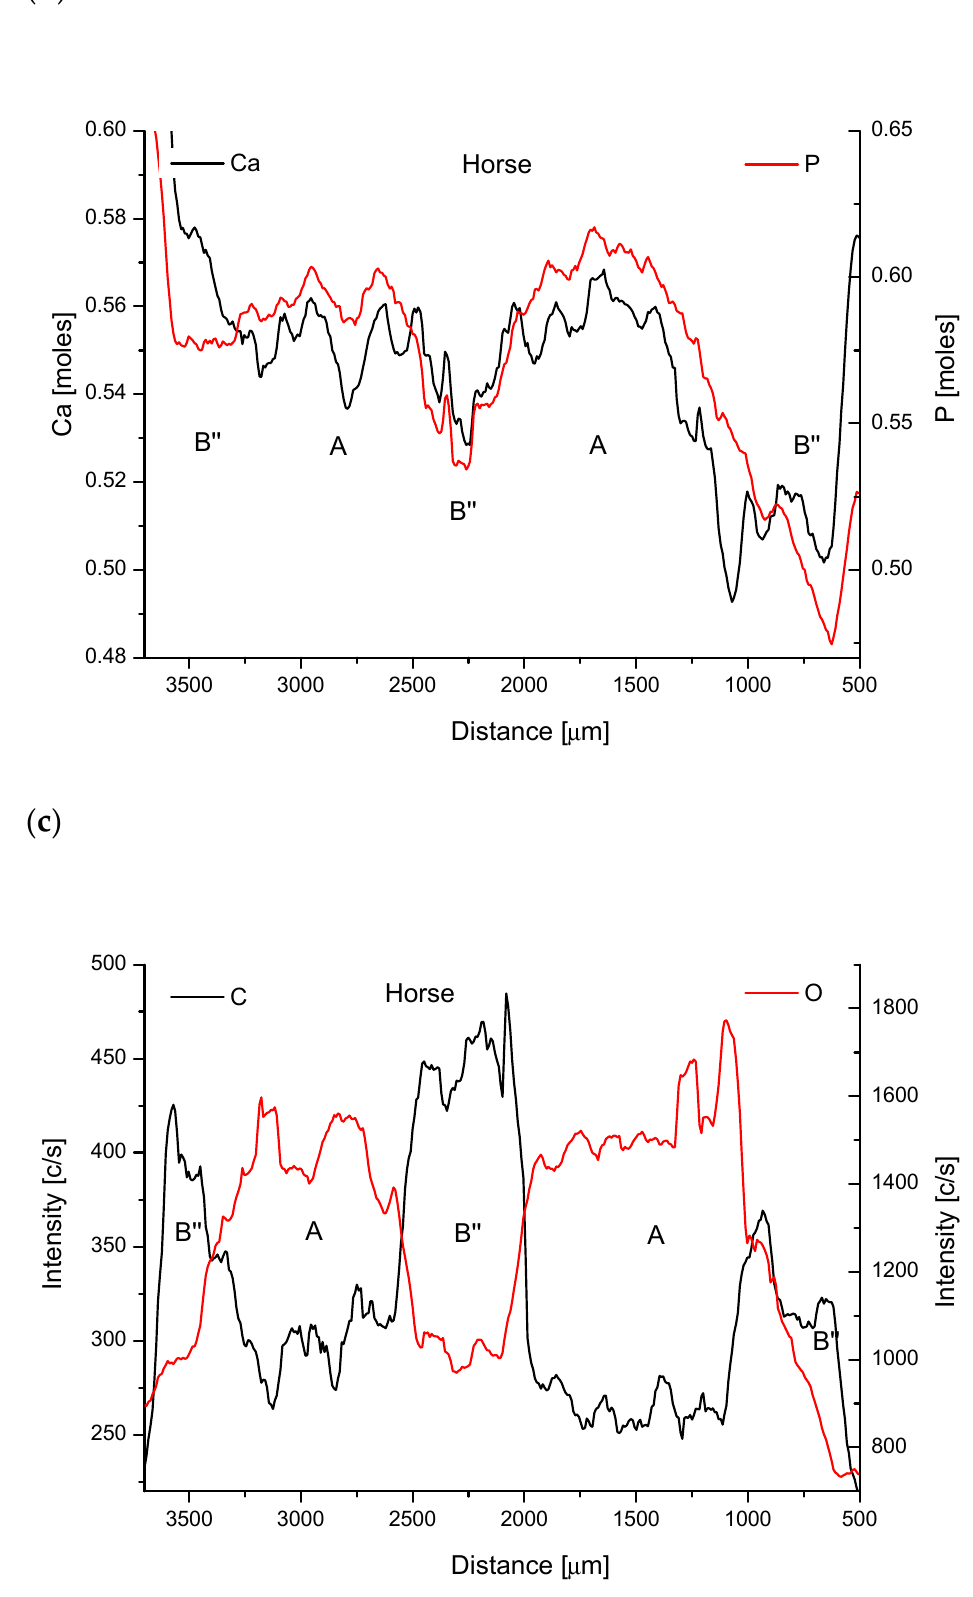
Figure 5. Oscillations of elements in horse tooth, shown in the pairs: ( a ) Mg-C; ( b ) Ca-P, ( c ) C-O. Letters a and b’’ indicate the kind of peculiar apatite in given zone.